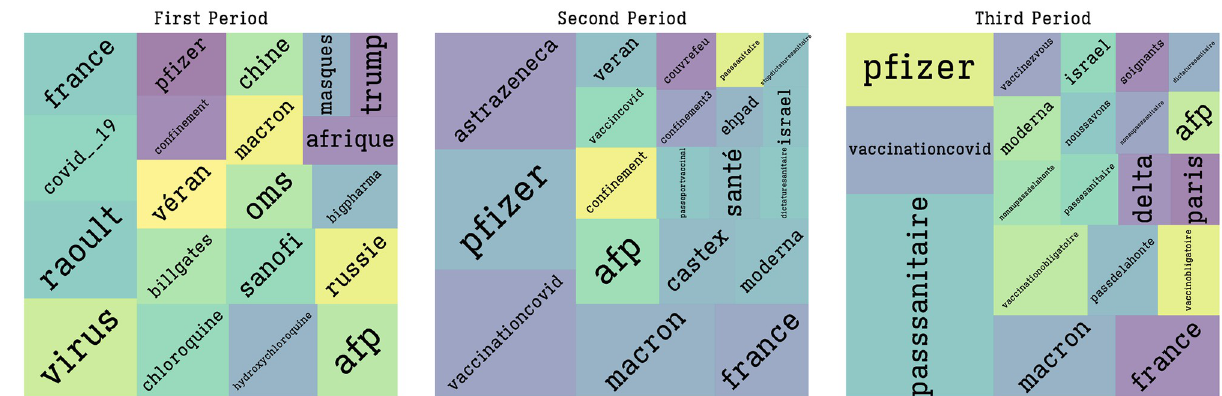
Fig 2. Treemap of the most important hashtags per period. Pre-Pfizer announcement; post-Pfizer announcement; Health pass discussion.